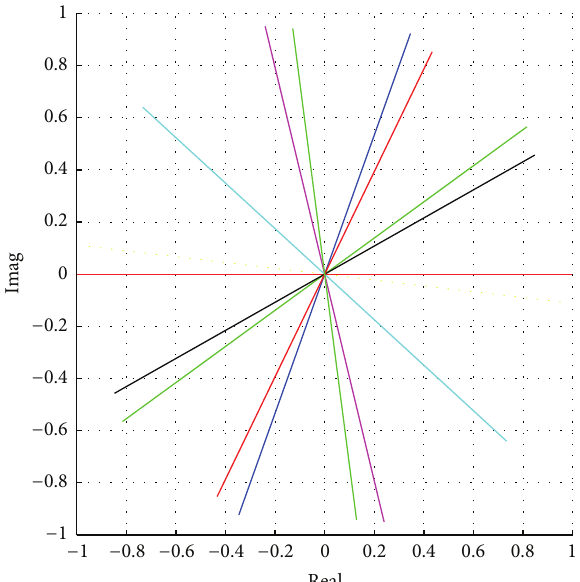
Figure 2: Eighth order, pole-weighted vector (state vector) example, top